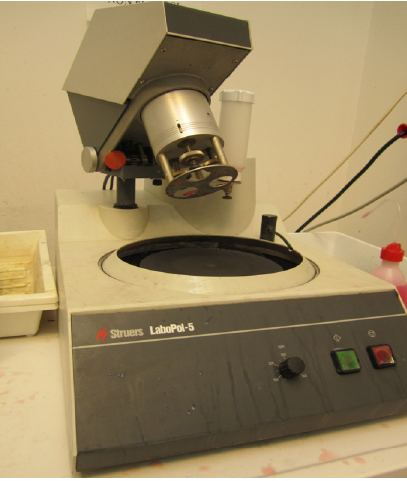
Figure 10. Struers polishing machine.